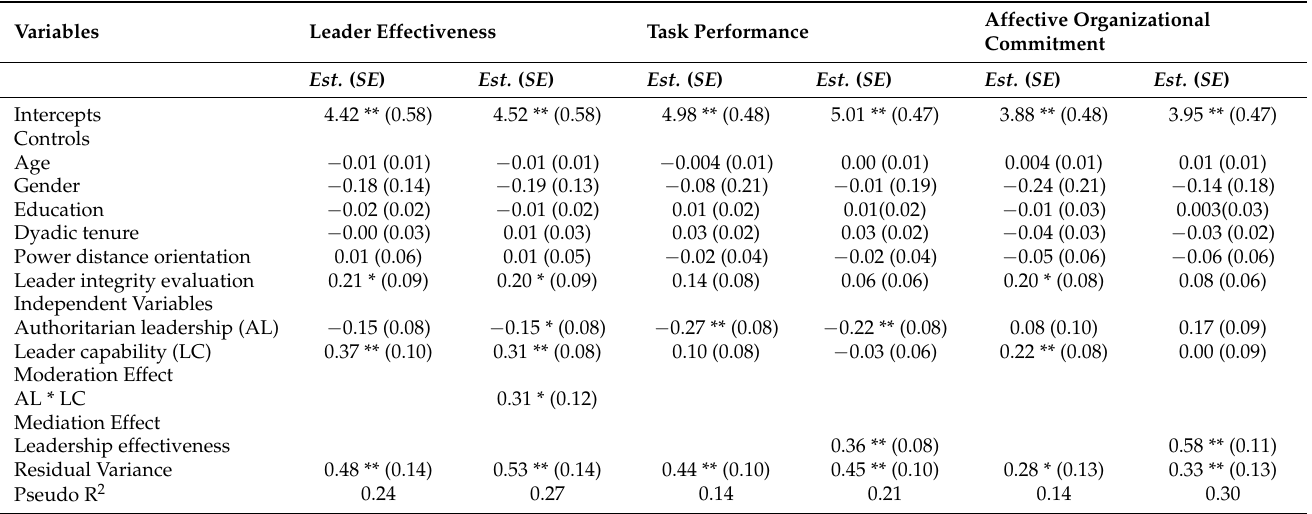
Table 2. Unstandardized